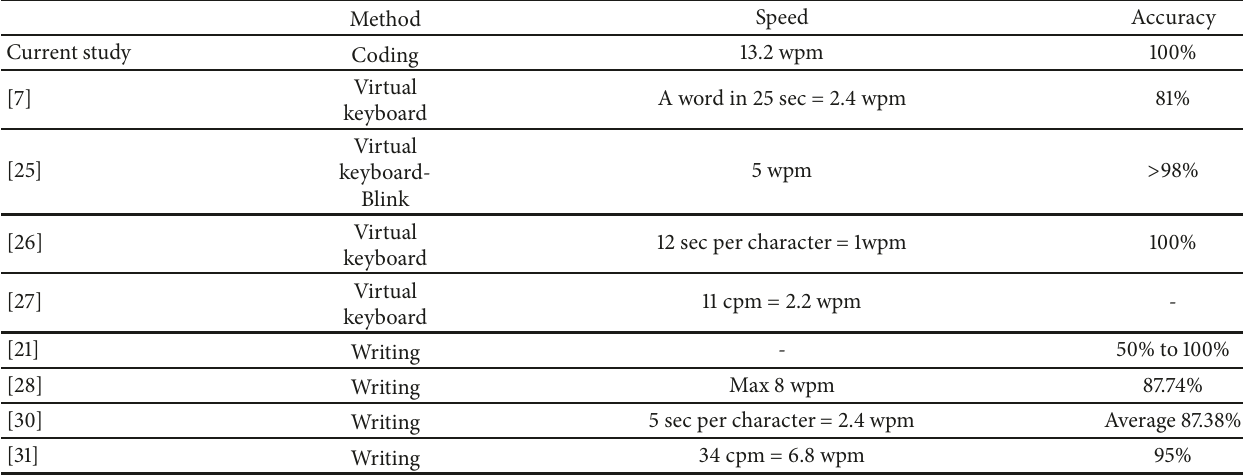
Table 3: Comparison of the EOG-based typing and writing